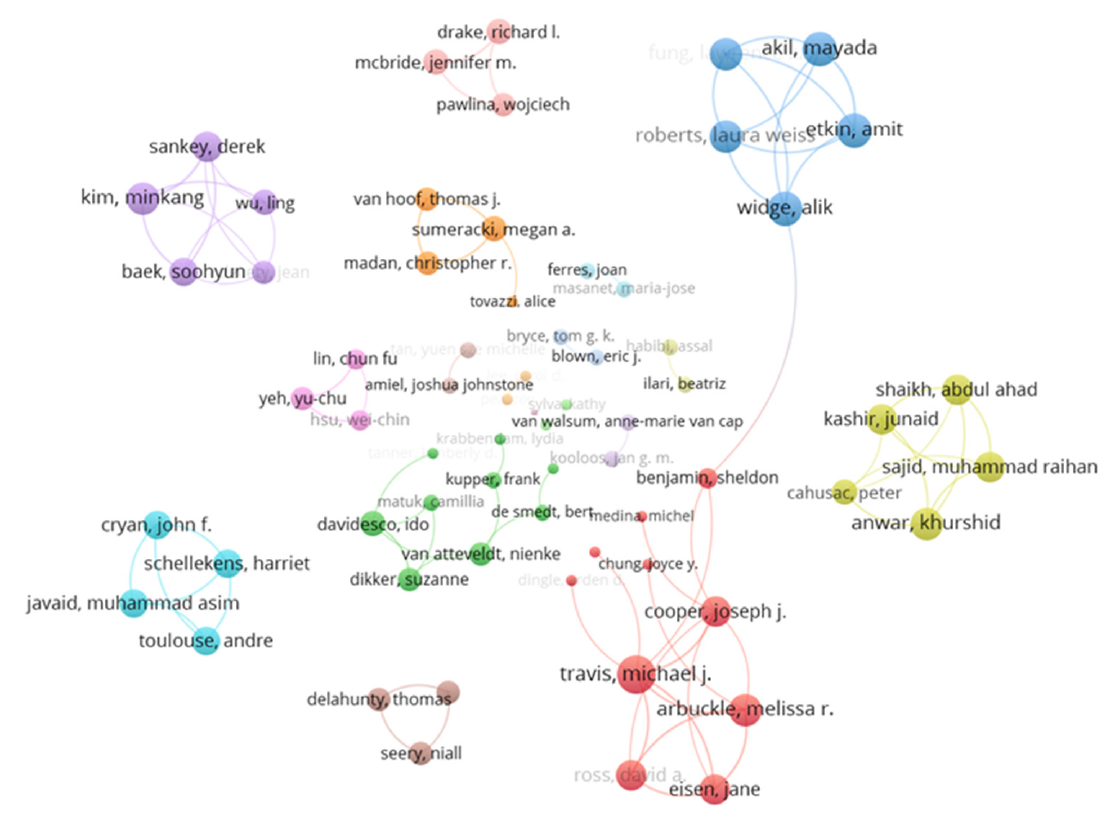
Figure 5. Author collaboration network.